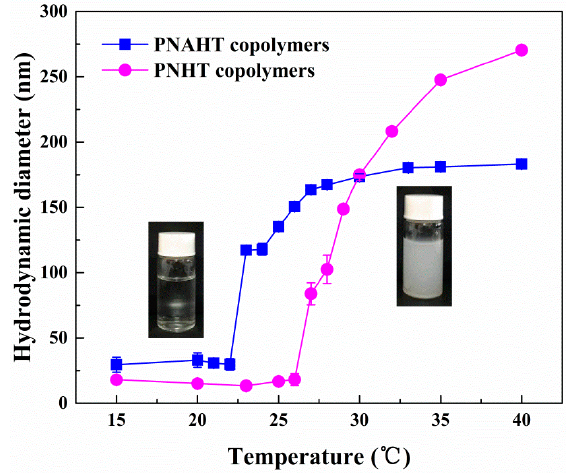
Figure 5. Changes in D AH of PNAHT and PNHT in UHQ water as plotted with temperature.